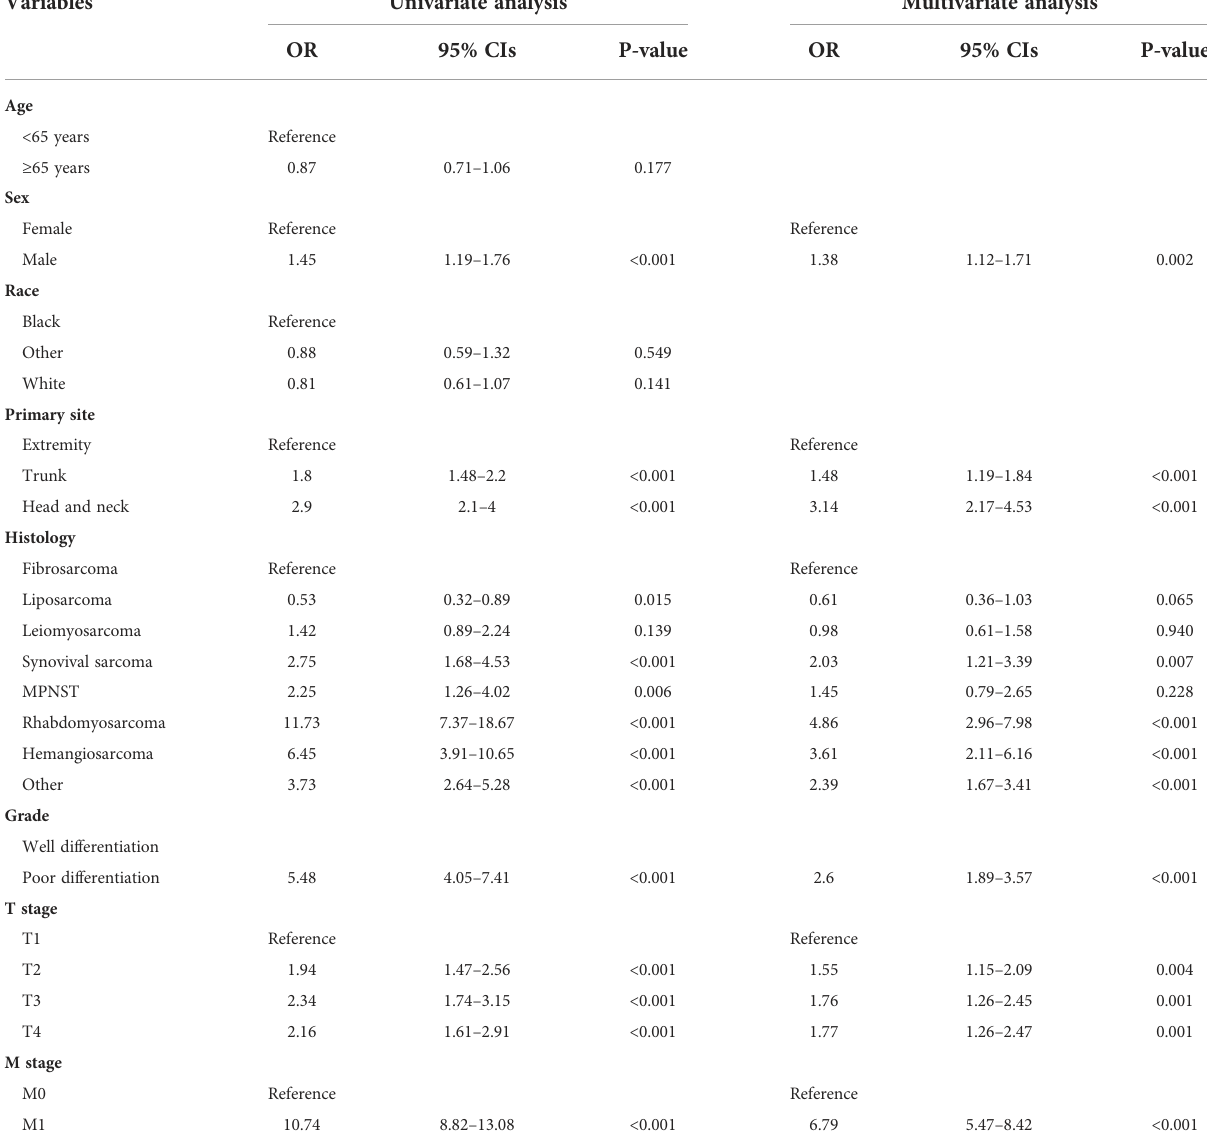
TABLE 3 Univariate and multivariate logistic analysis to determine the independent risk factors of lymph node metastasis in patient with soft tissue